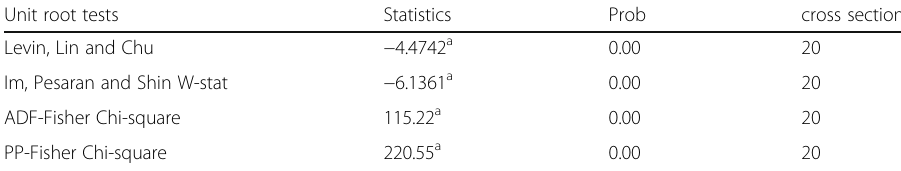
Table 12 Residual panel unit root